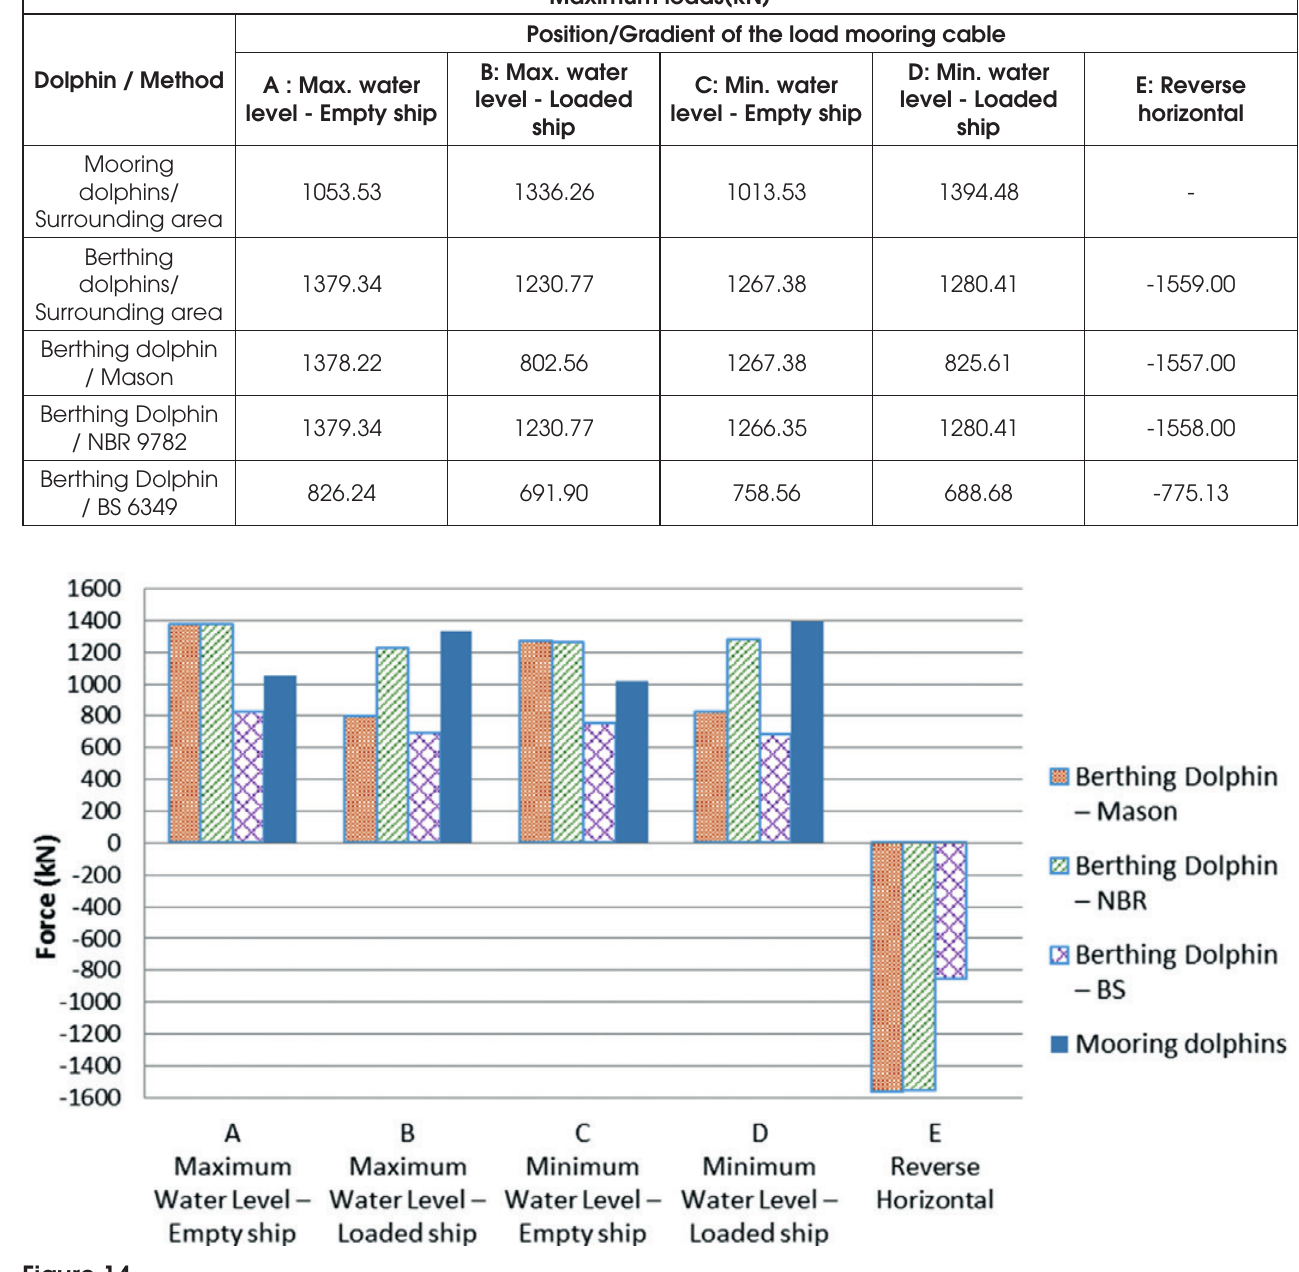
Maximum loads on dolphins due to mooring for each cable gradient or position, by